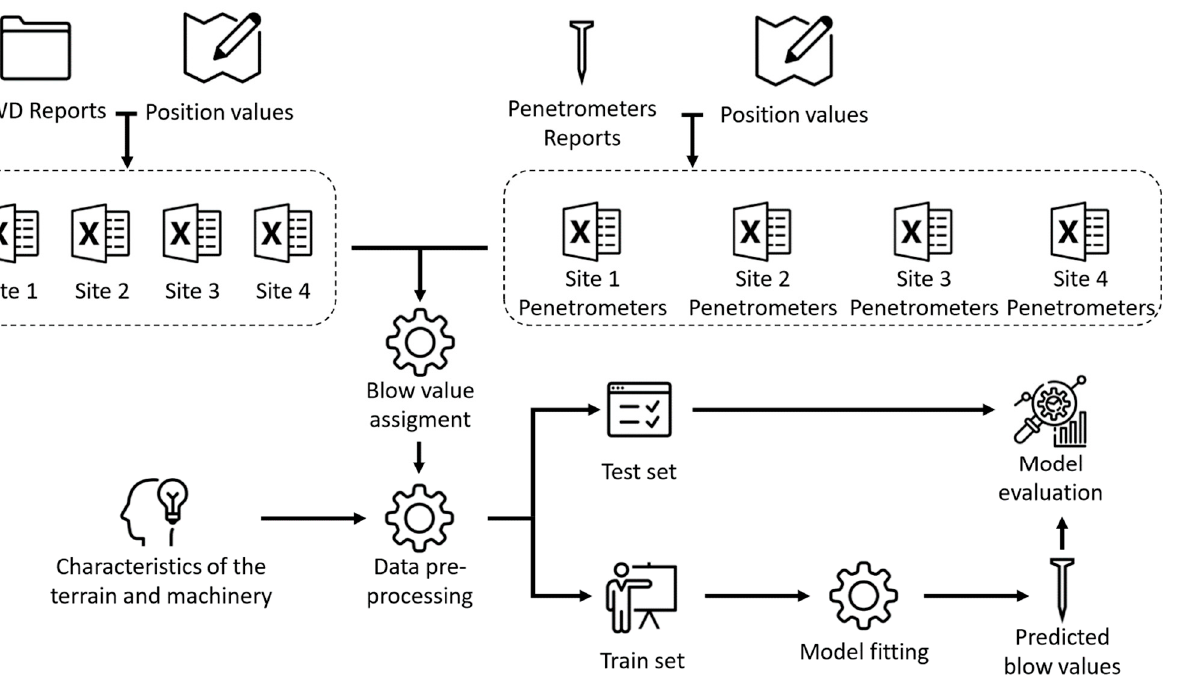
Figure 3. Procedure applied in the analysis.